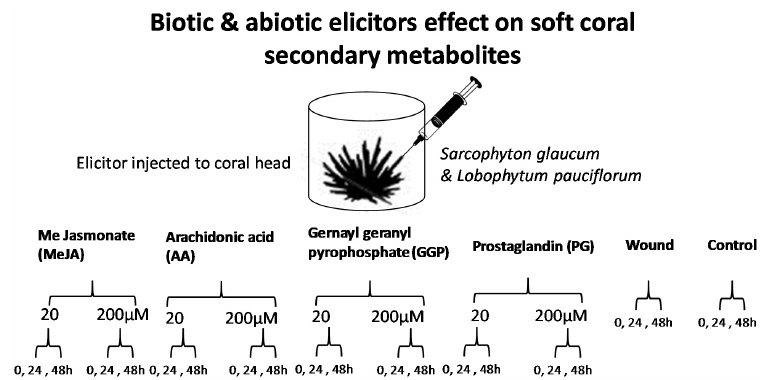
Figure 1. Elicitors application to soft corals and temporal sampling theme used in this study.